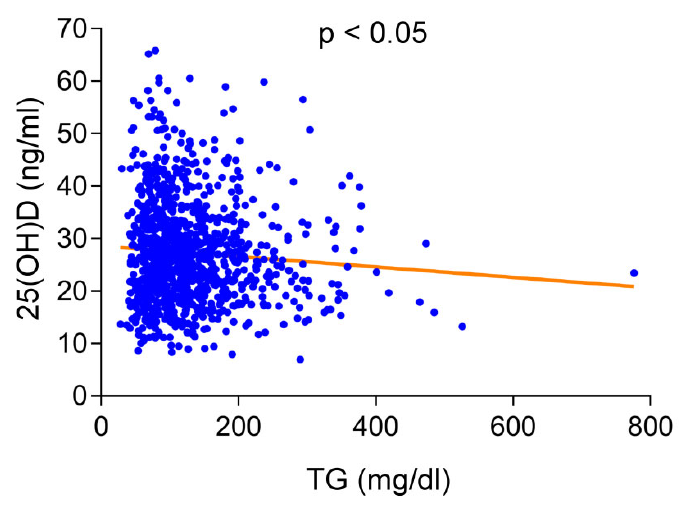
Figure 1. Correlations between serum levels of 25 ‐ hydroxyvitamin D (25(OH)D) and triglyceride (TG) levels in total study population. Increased serum TG levels were significantly associated with decreased 25(OH)D levels.